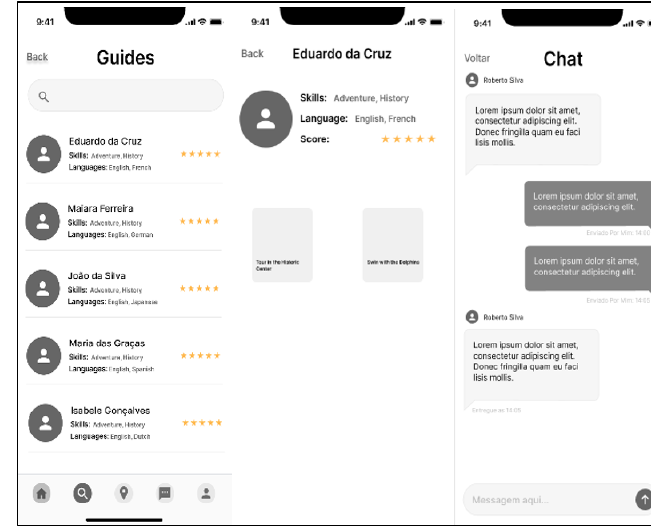
Figure 8: Search screens for tour guides, details and chat. Source: Authors,